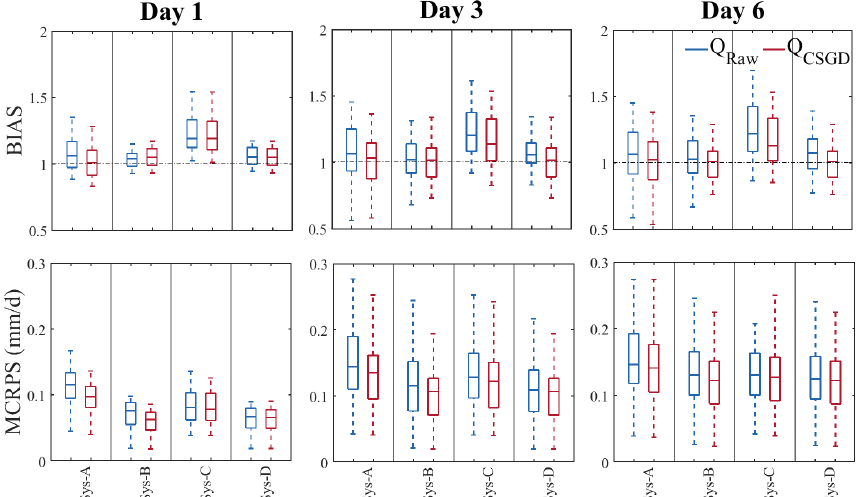
Figure 6. Relative bias (BIAS) and MCRPS of the ensemble streamflow forecasts of the four hydrological prediction systems and lead times 1, 3, and 6d when considering raw (blue) and post-processed (red) precipitation forecasts. Box plots represent the score variability over the 30 catchments.